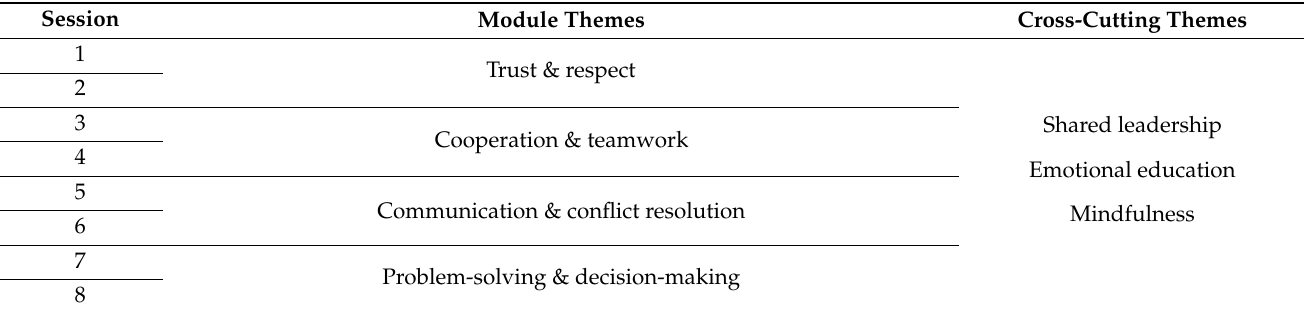
Table 2. Session-specific topics in the bouldering